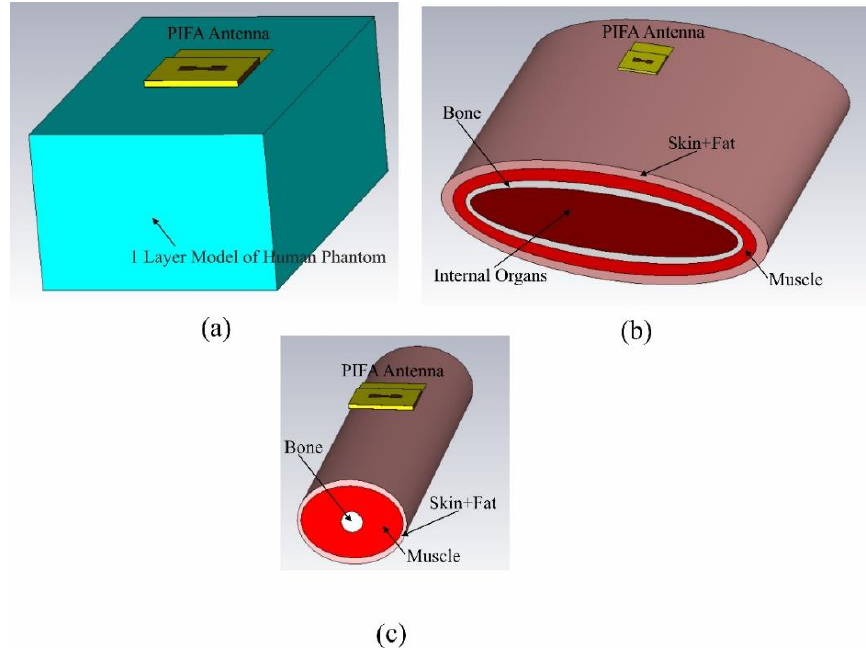
Figure 18. ( a ) One-layer model (tissue-simulating liquid with muscle-like parameters), with ε r = 56.6 and σ = 1.33 S/m. ( b ) Simplified model of the human torso, with parameters: Skin + fat ellipse axes 50 × 20 cm, ε r = 14.5 and σ = 0.25 S/m .; Muscle ellipse axes 46.5 × 17 cm, ε r = 55.1 and σ = 0.93 S/m ; Bone ellipse axes 42.6 × 12.6 cm, ε r = 20.8 and σ = 0.33 S/m; Internal organs ellipse axes 41 × 10 cm, ε r = 52.1 and σ = 0.91 S/m. ( c ) Simplified model of the human arm, with parameters: Skin + fat ellipse axes 10 × 8 cm, ε r = 14.5 and σ = 0.25 S/m; Muscle ellipse axes 9.5 × 7.5 cm, ε r = 55.1 and σ = 0.93 S/m.; Bone ellipse axes 2 × 2 cm, ε r = 20.8 and σ = 0.33 S/m .